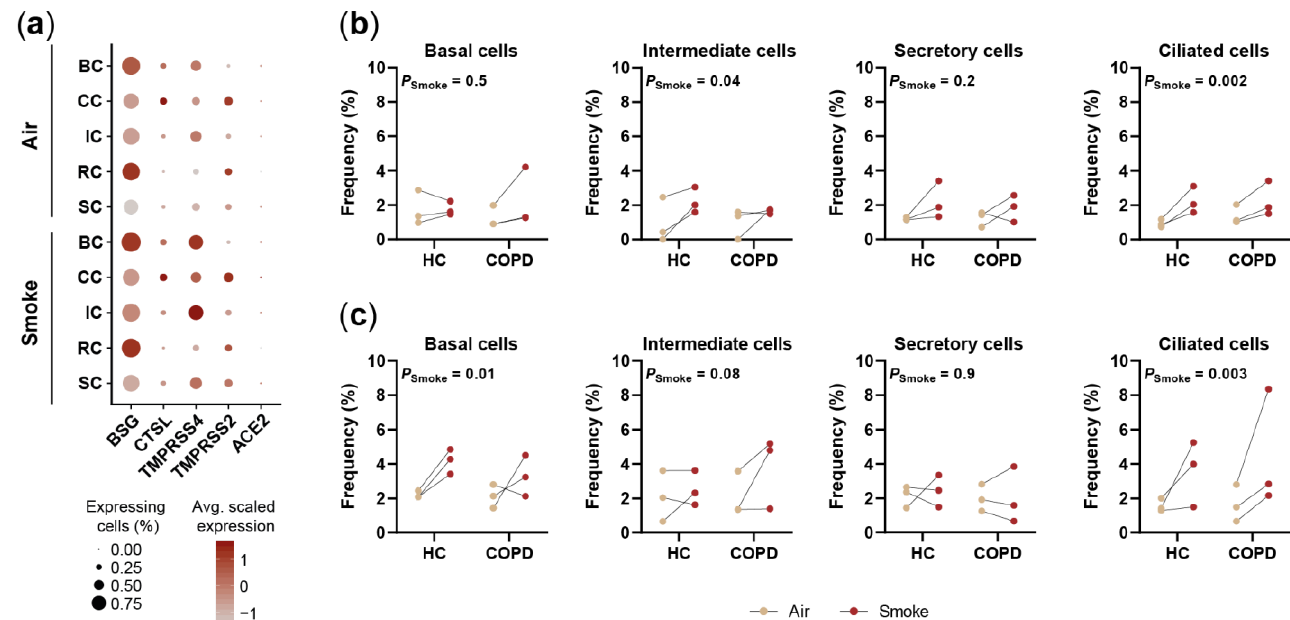
Figure 7. Smoke exposure affects the expression of SARS-CoV-2 entry factors in SAEC populations. ( a ) Dot plot illustrating the average relative expression and fraction of cells that express genes encoding for SARS-CoV-2 entry factors across the main SAEC populations. ( b , c ) Smoke induced shifts of ACE2 + cell frequency in SAEC ALI cultures from HC and COPD donors ( n = 3, each). Effects are shown for acute ( b ) and chronic ( c ) smoke exposure.